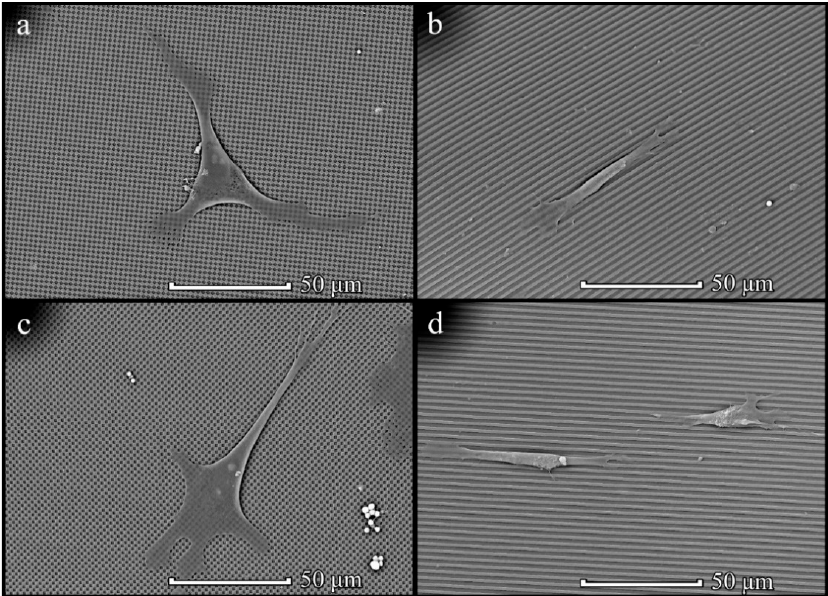
Figure 11. SEM images of MSCs on patterned films prepared on stamps: PHB350 TGX1 (TipsNano) ( a ), PHB350 TGZ3 (TipsNano) ( b ), PHB- co -HV(17%) TGX1 (TipsNano) ( c ) and PHB- co -HV(17%) TGZ3 (TipsNano) ( d ) polymers.